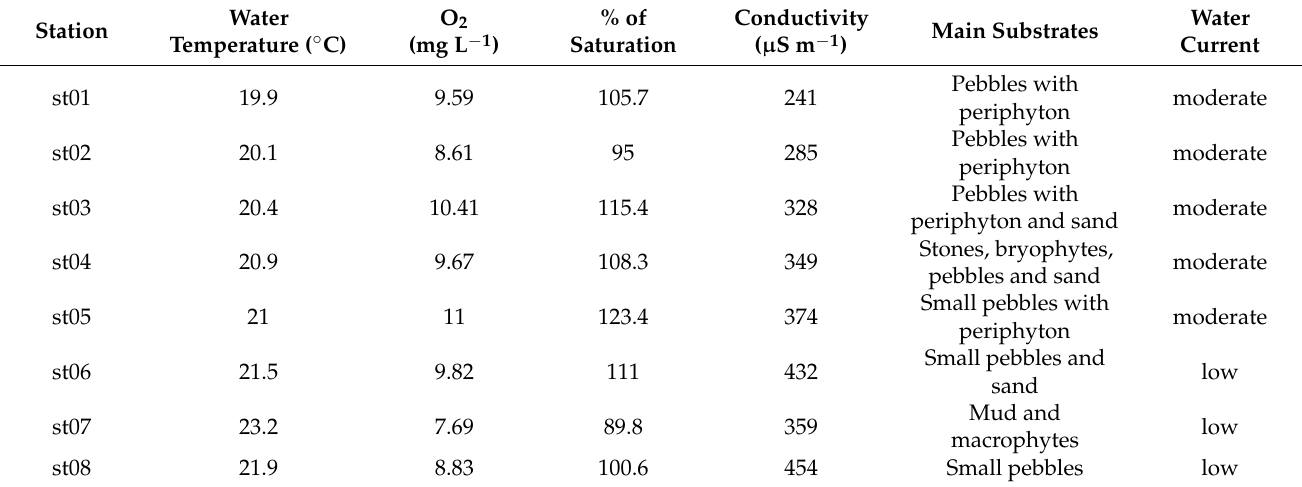
Table 1. Main environmental parameters recorded during the